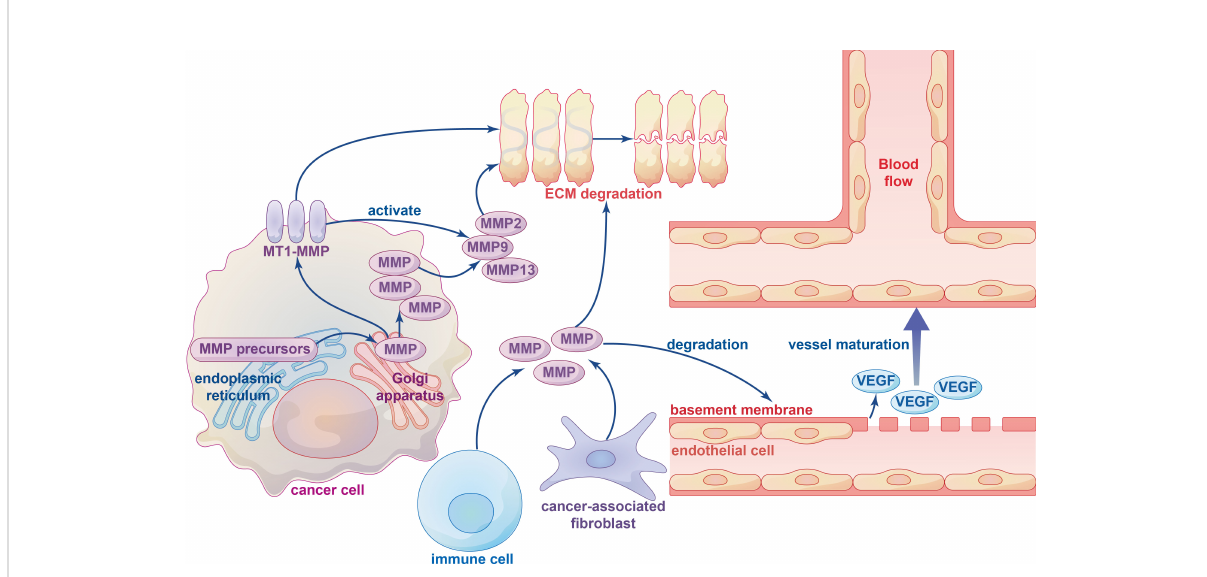
FIGURE 3 The in fl uence of metalloproteinases on ECM degradation and angiogenesis. Various types of metalloproteinases in ECM-degrading are fi rstly synthesized as inactive precursors (zymogens) in the endoplasmic reticulum and then transported to the Golgi apparatus, which can be divided into membrane-type 1 matrix metalloproteinase (MT1-MMP) and other soluble MMPs. Several immune cells and cancer-associated fi broblasts (CAFs) can also produce metalloproteinases. ECM degradation is mainly performed by MT1-MMP-activated soluble MMPs, such as soluble gelatinases MMP2, MMP9 and soluble collagenase MMP13. The MMPs degrade the basement membrane structure of vascular endothelial cells and release VEGF bound to the extracellular matrix to initiate vessel